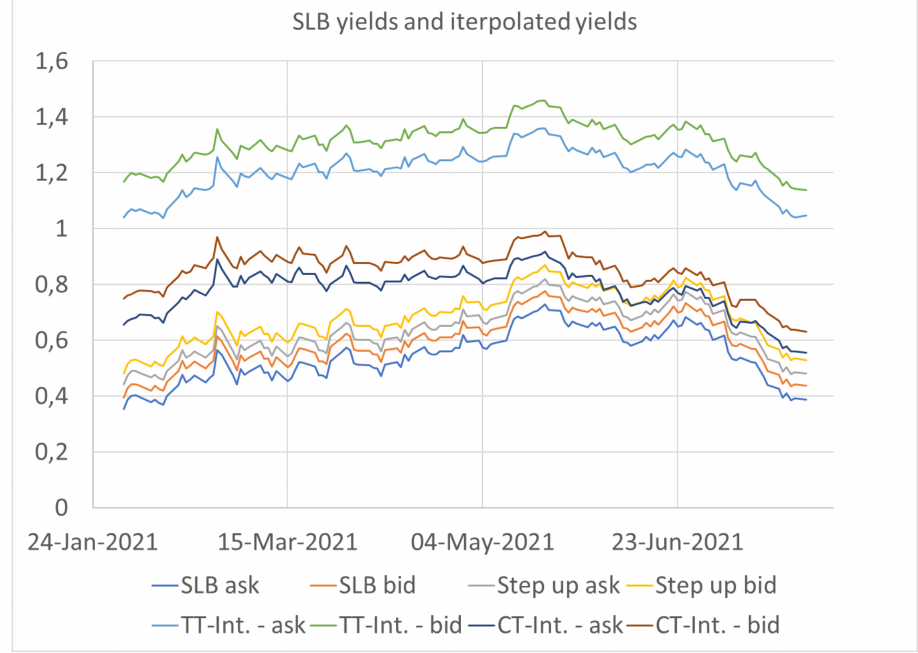
Figure 3. SLB yields and interpolated yields in